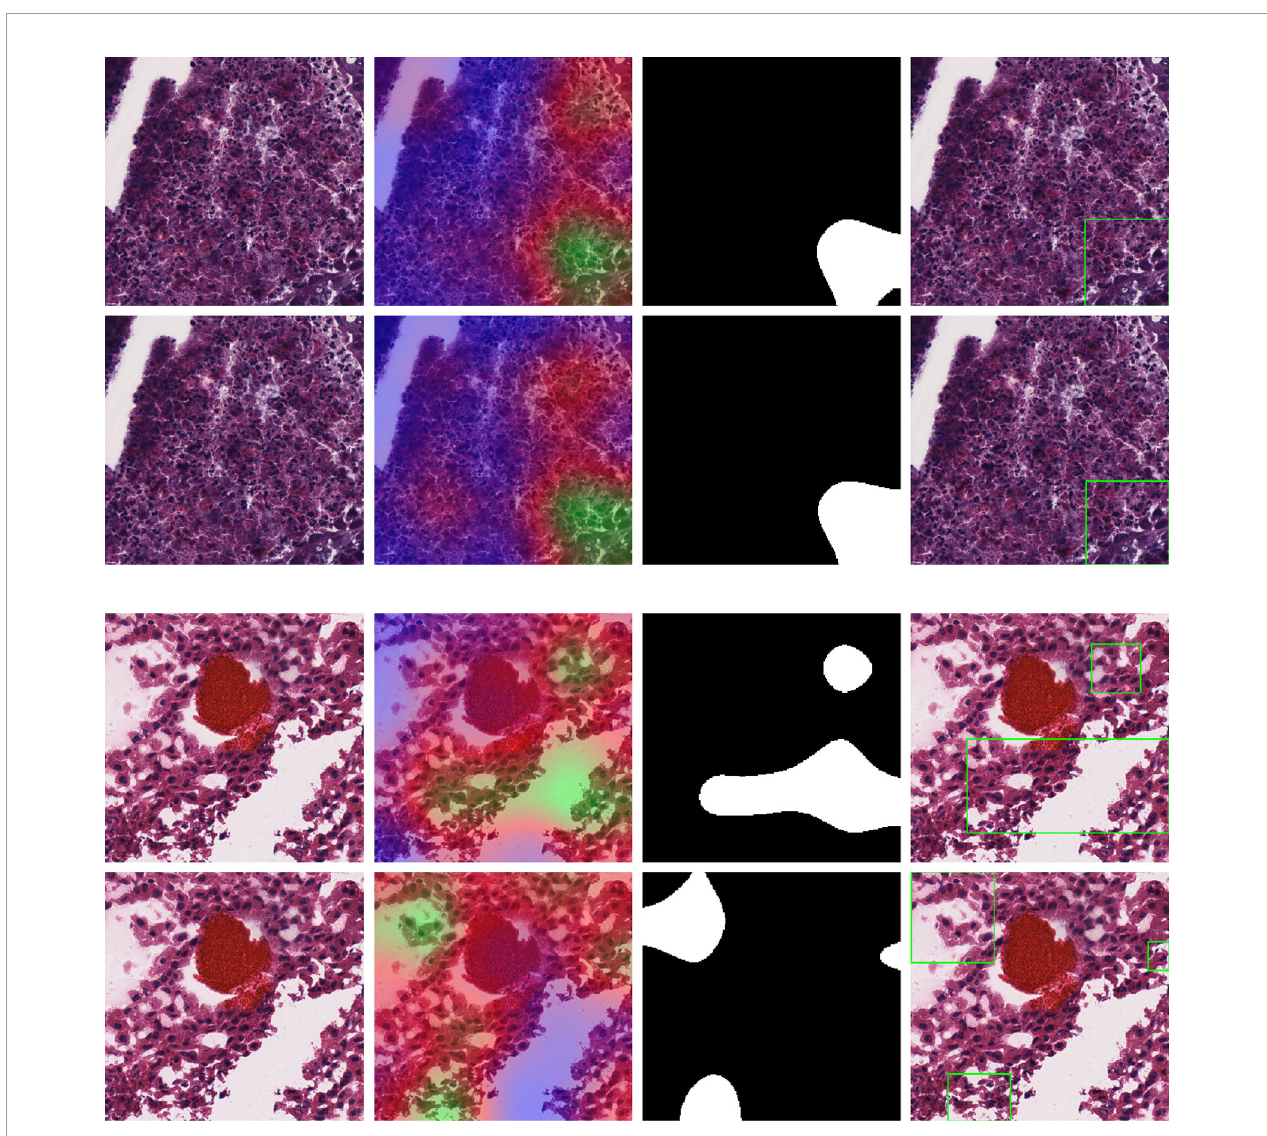
FIGURE 8 | Cross-organ GradCAM visualization of the BRCA model on COAD and KICH cancer patches. Columns show the input patch, GradCAM output, GradCAM thresholded, and GradCAM with bounding box, respectively. Top 2 rows show COAD input patches and visualization using the BRCA model (1st row) and COAD model (2nd row). Bottom 2 rows show KICH input patches and visualization using the BRCA model (3rd row) and KICH model (4th